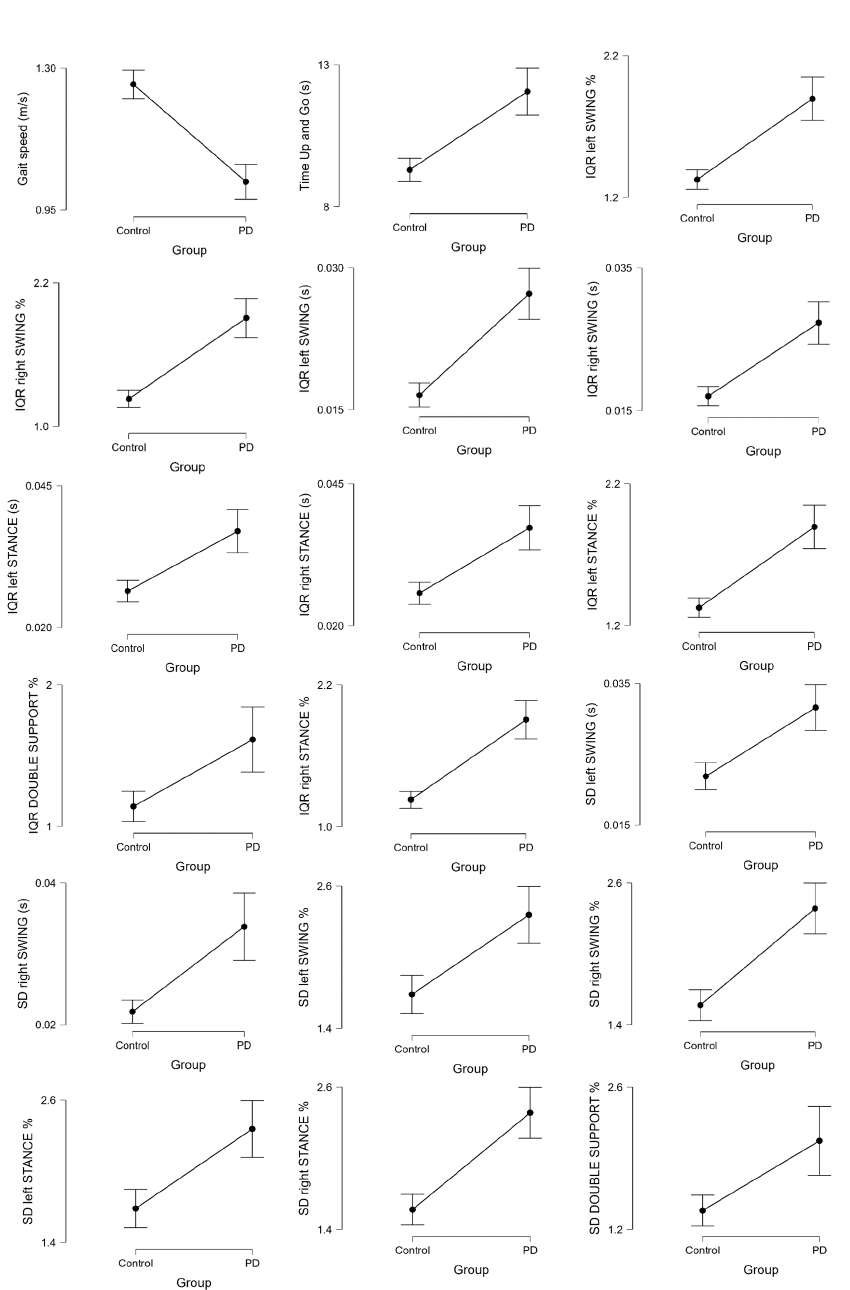
Figure 4. Average values of kinematic central tendency indices (gait speed and Time Up and Go) and dispersion indices of PD patients and HS with significant differences on the t -test. IQR = interquartile range. SD = standard deviation.